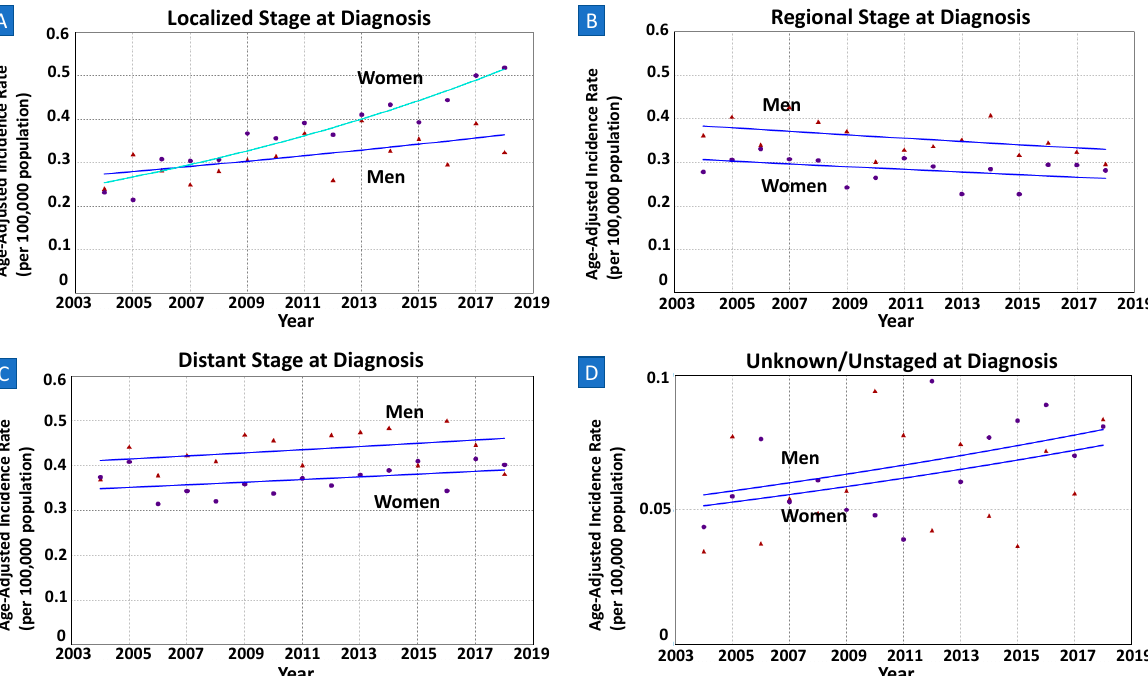
Figure 4. ( A – D ) Sex-specific incidence trends among younger adults by staging at diagnosis. All data are from SEER database, among those of age < 55 years. Lines of both men and women are same colors if trends are parallel, meaning same APC and AAPC values during the interval years. ( A ) Among patients with localized stage of disease at diagnosis, women had higher increase in incidence than men (AAPC 5.17% vs. 2.04%; p -value < 0.03). ( B – D ) Among those with regional, distant, or unknown/unstaged staging at diagnosis, the trends between men and women were parallel ( p -values 0.47, 0.94, 0.37, respectively).